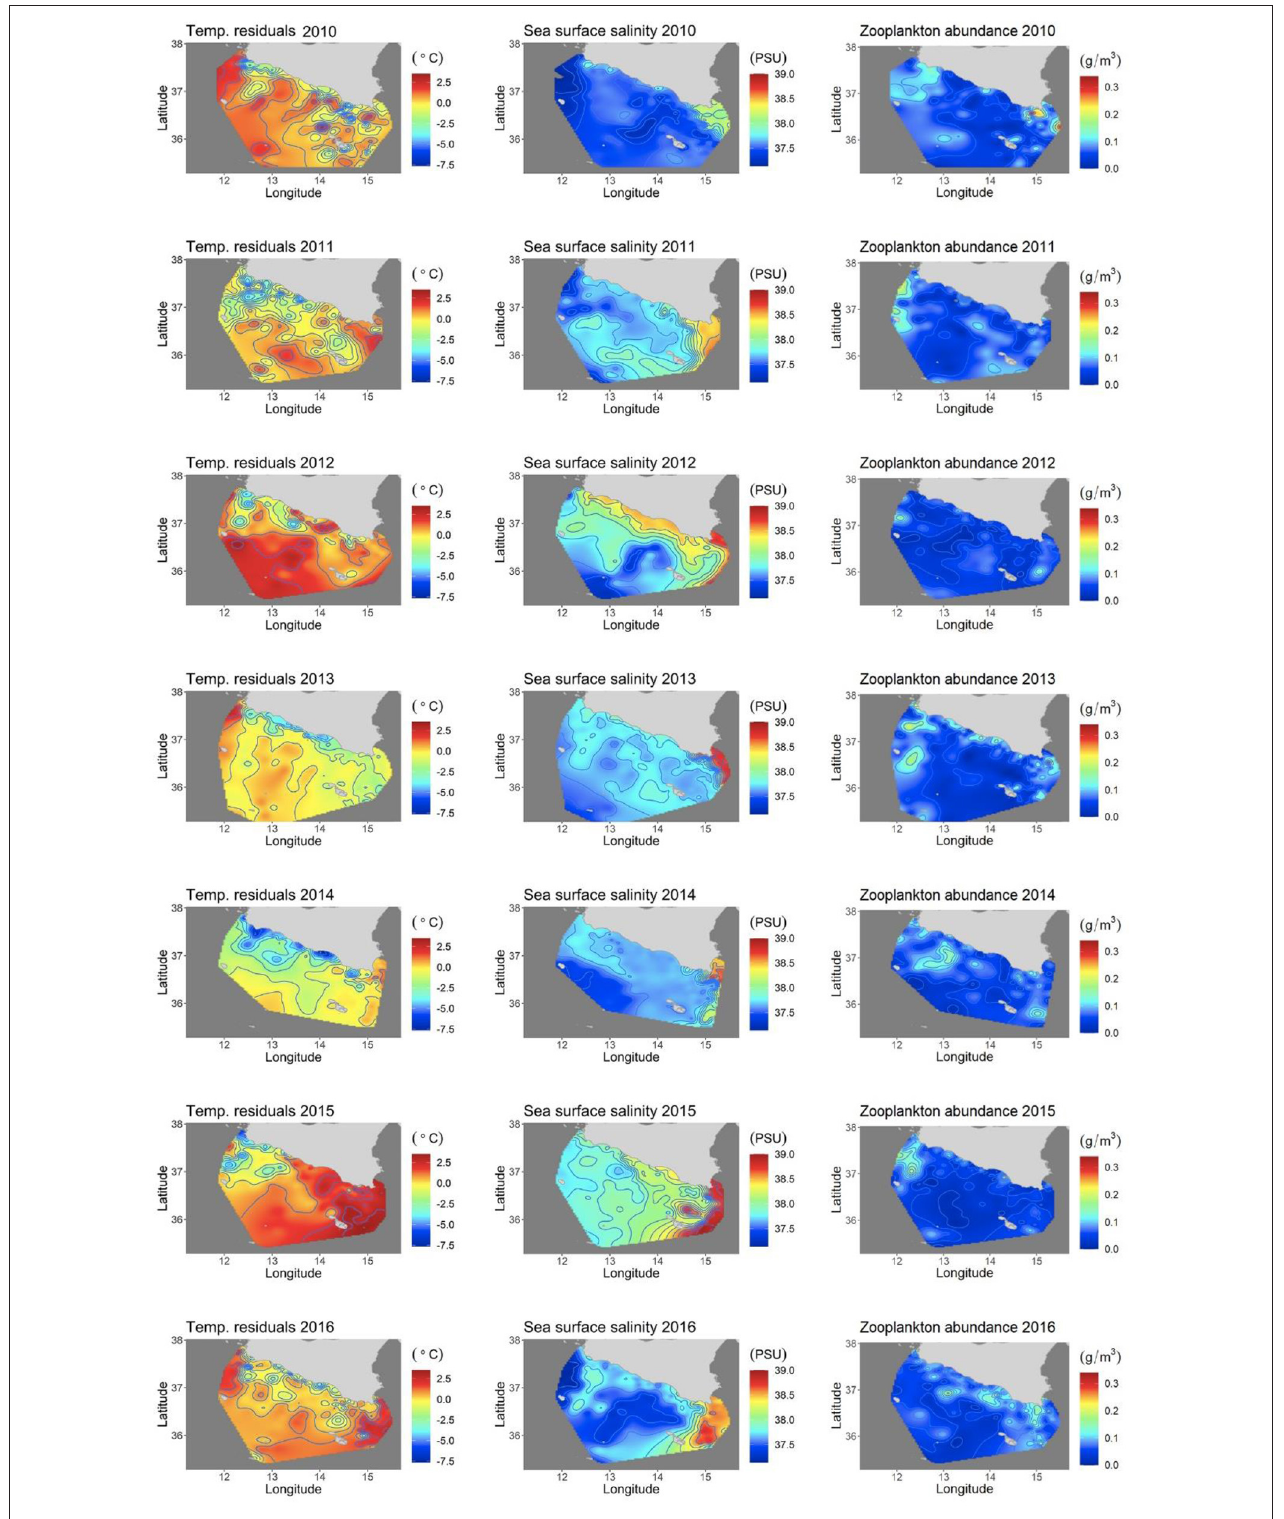
FIGURE 2 | Generalized additive model (GAM) covariates considered in the models. Temperature anomalies in the first column, salinity in the second column, and zooplankton abundance (g/m 3 ) in the third column.